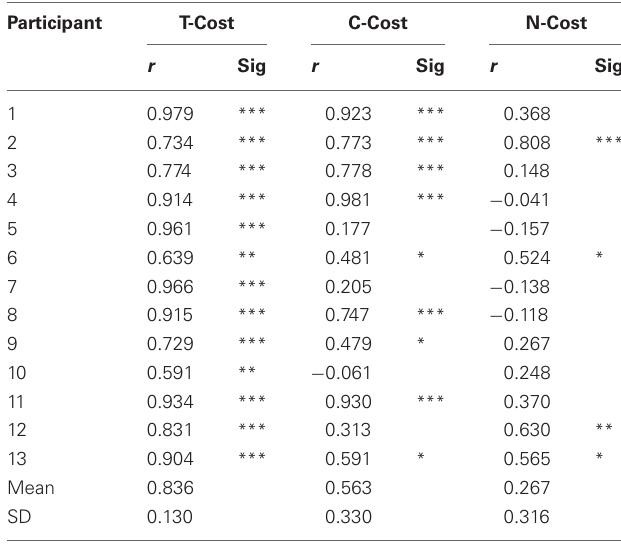
Table 1 | Results of correlations between error and T-Cost, C-Cost, and N-Cost (Pearson correlation coefficients r